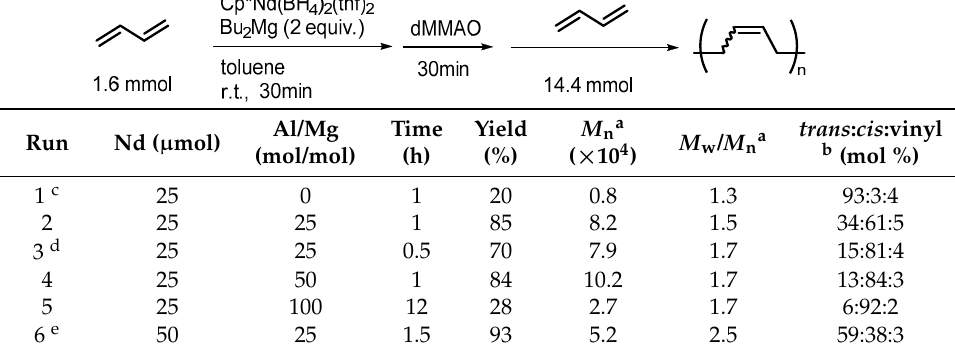
Table 1. Butadiene polymerization using the Cp*Nd(BH 4 ) 2 (thf) 2 –Mg/Al catalyst system.